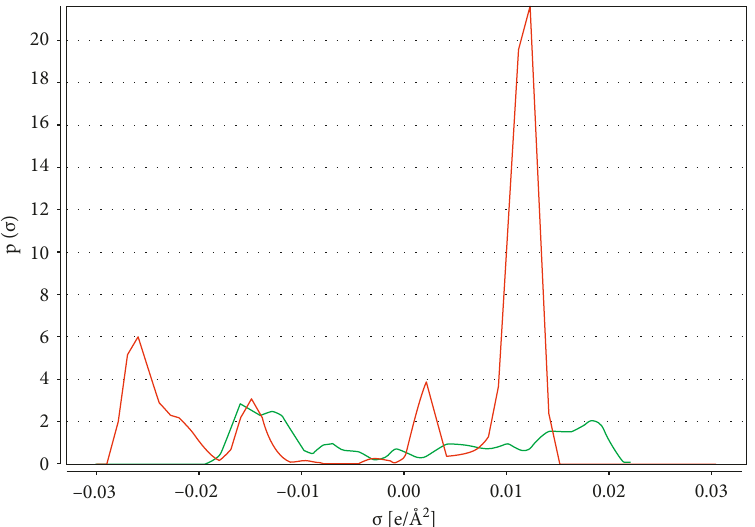
Figure 3: The sigma profile and sigma potentials of the CaCl2–H2O system ( NaCl and H